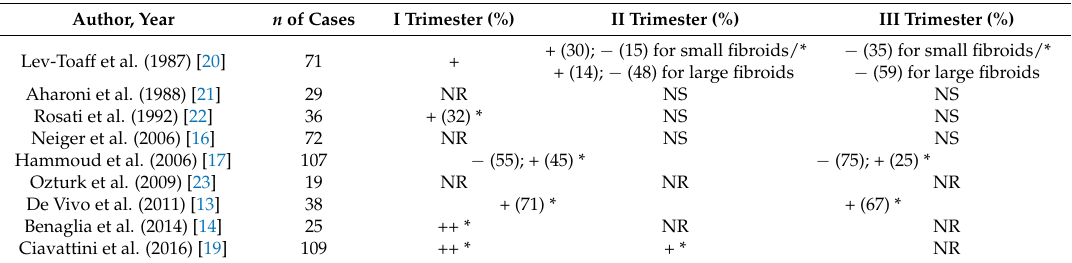
Table 1. Pattern of growth of uterine leiomyomas during pregnancy, cases reported in